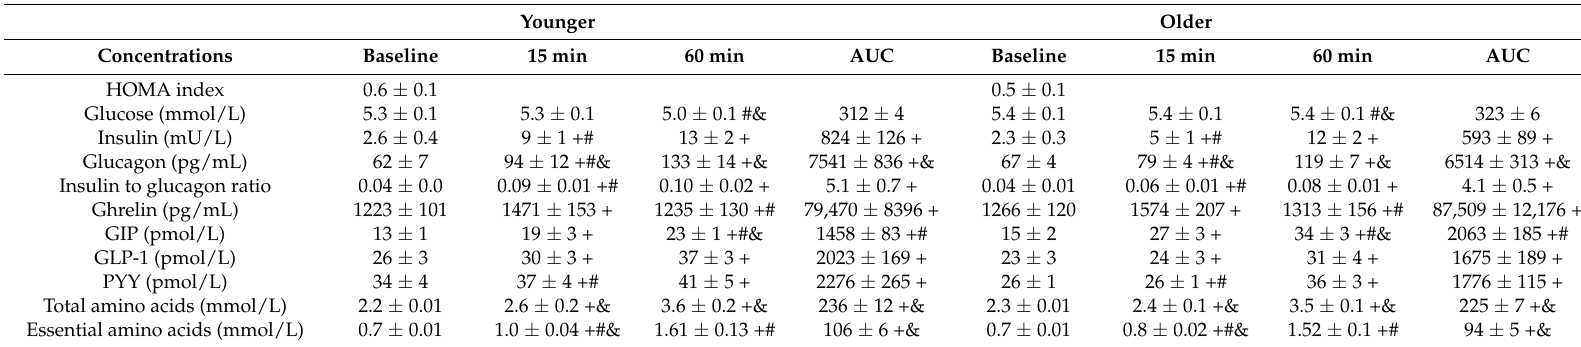
Table 1. 15 min, 60 min, and AUC blood glucose, plasma insulin, glucagon, ghrelin, GIP, GLP-1, PYY, total and essential amino acid concentrations, and the ratio of insulin to glucagon and HOMA-IR in healthy younger and older